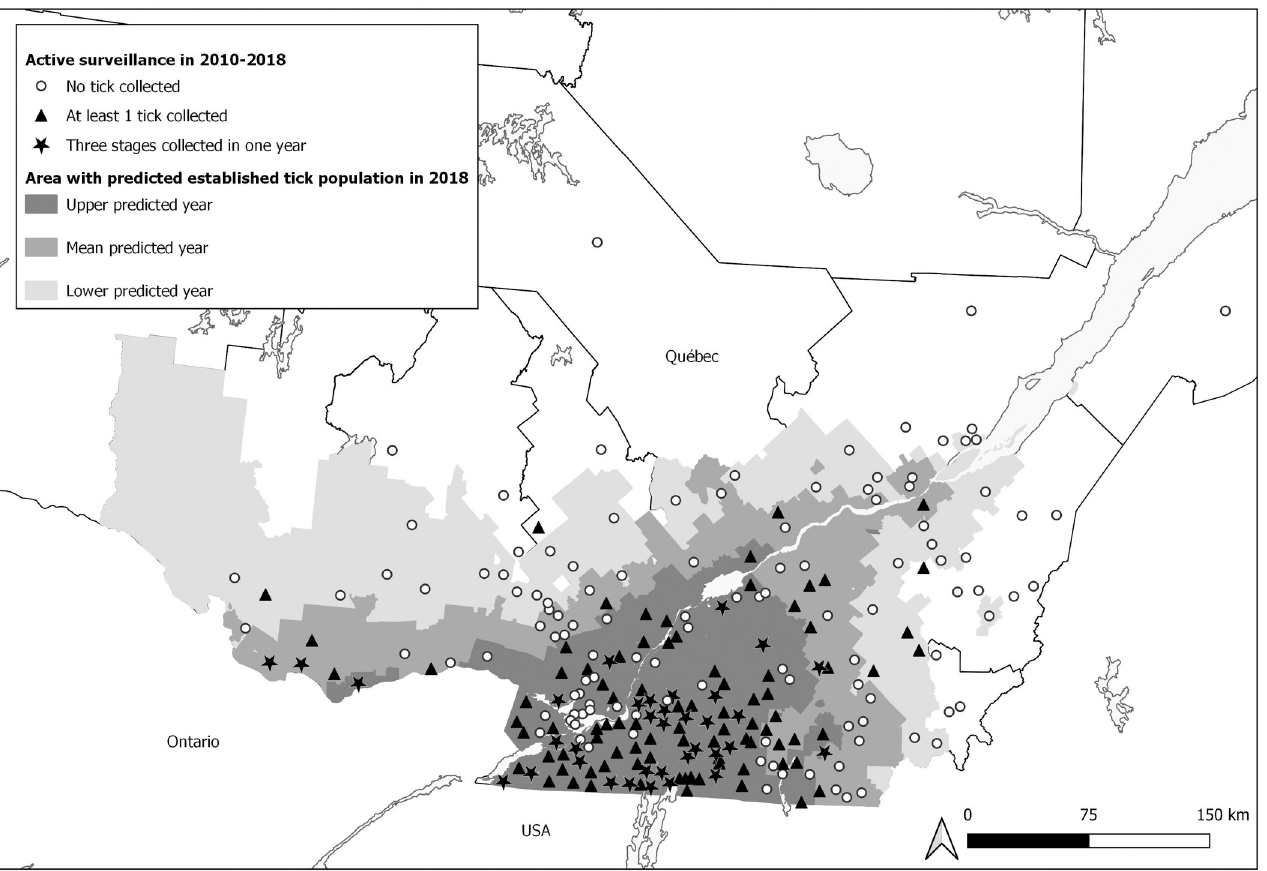
Fig 1. Tick surveillance in Que´bec municipalities, 2010–2018, and predicted tick population establishment by 2018. Active surveillance from 2010 to 2018: municipalities with detection of three stages are indicated by black stars; those with the presence of at least one tick by black triangles and those with no tick detection by white circles. Shaded areas of the map show municipalities with predicted tick population establishment by 2018 according to the lower, mean and upper predicted year (light, medium and dark grey zones, respectively).